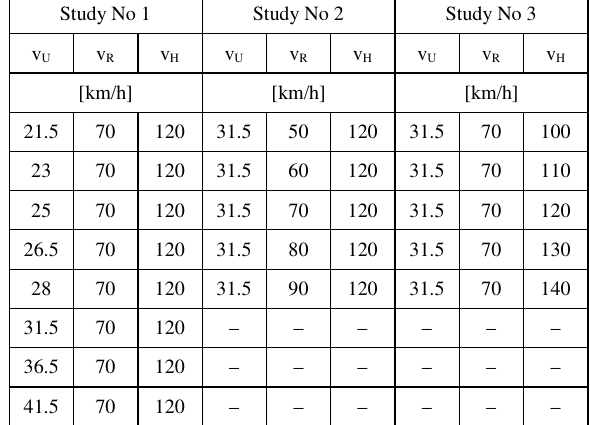
Fig. 3. Dependence of the national annual emission of carbon monoxide from passenger cars upon the average velocity, under model conditions of traffic on highways and expressways